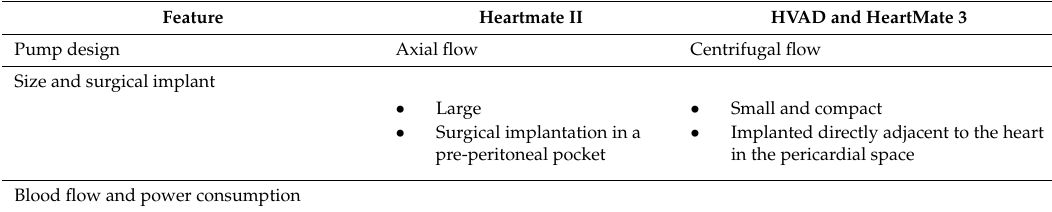
Table 2. Major Di ff erences Among the Current